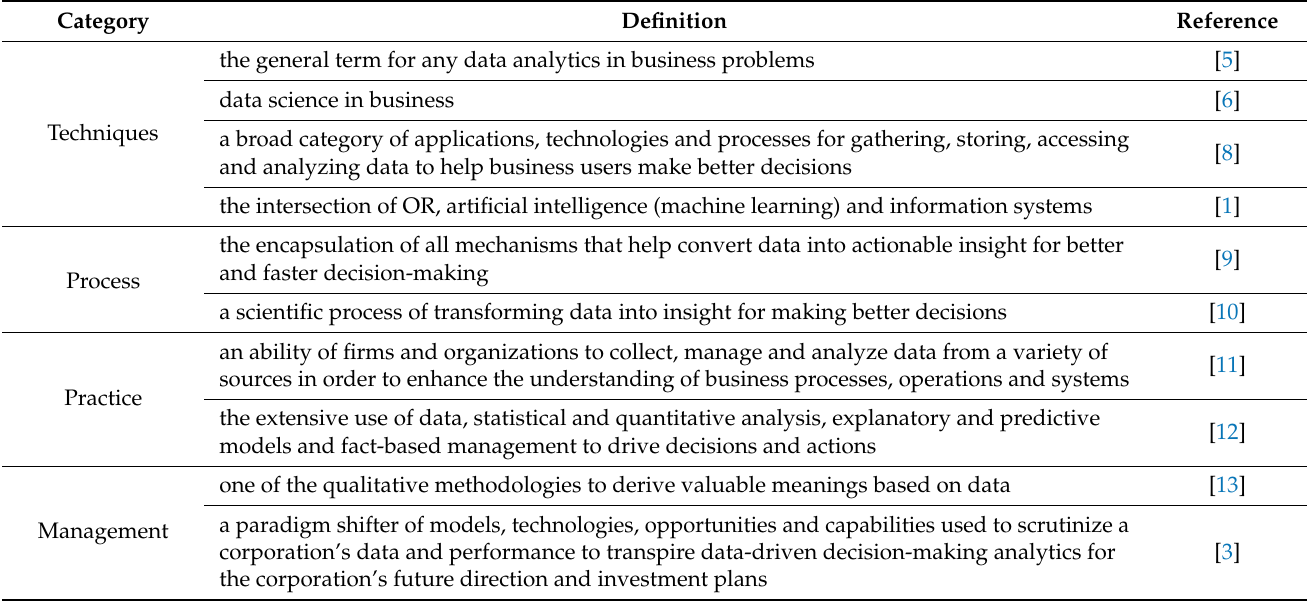
Table 1. Summary of